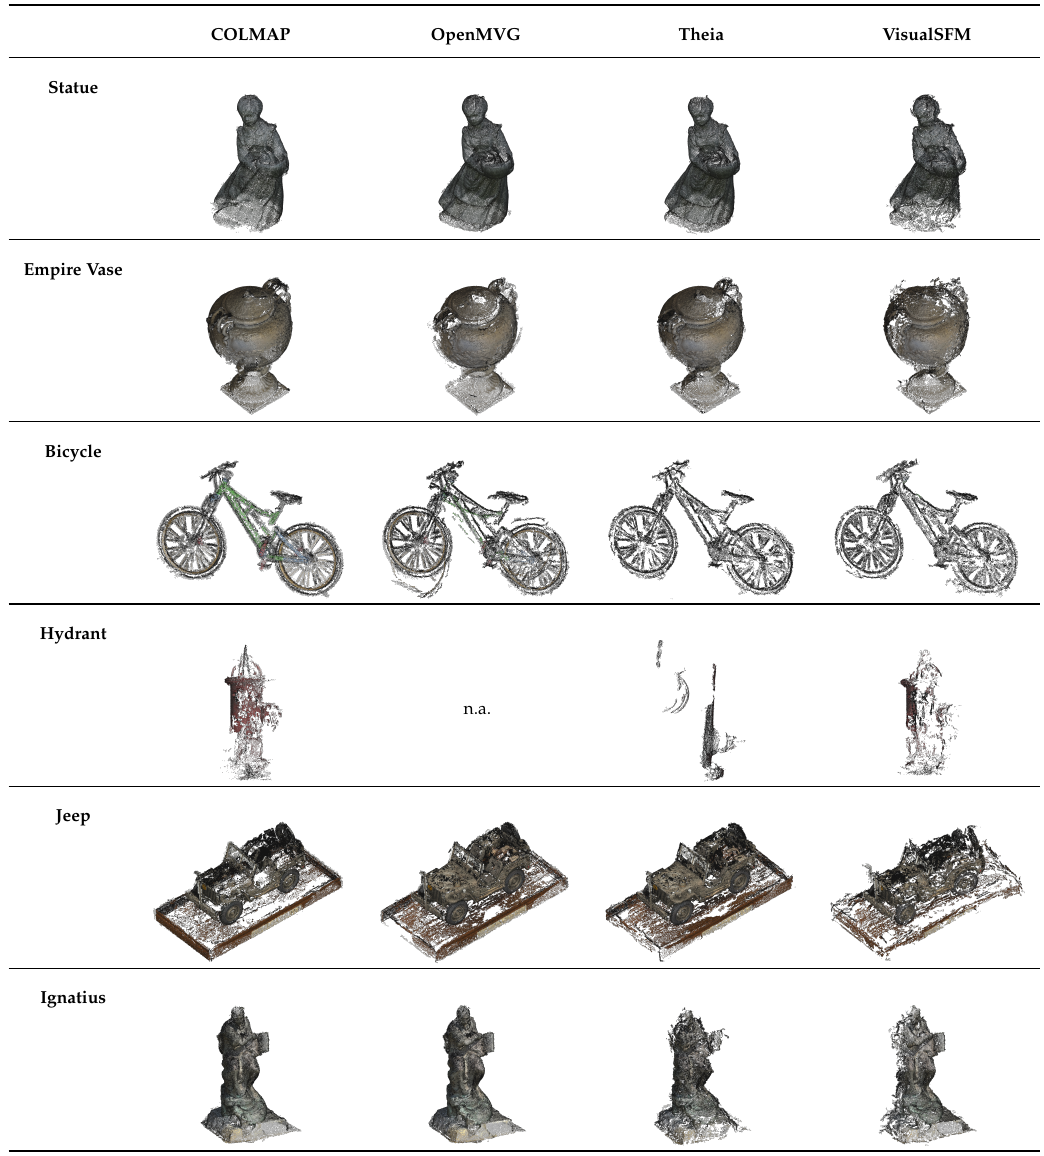
Table 6. Example of dense point clouds using CMVS/PMVS on different SfM